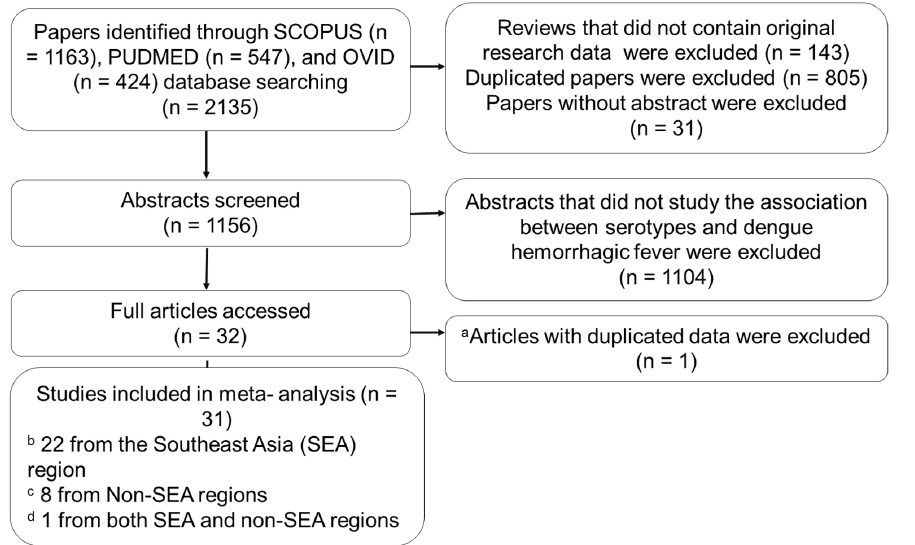
Fig 1. Flow chart of the study selection process. Studies [8,11 – 41] were cited in this